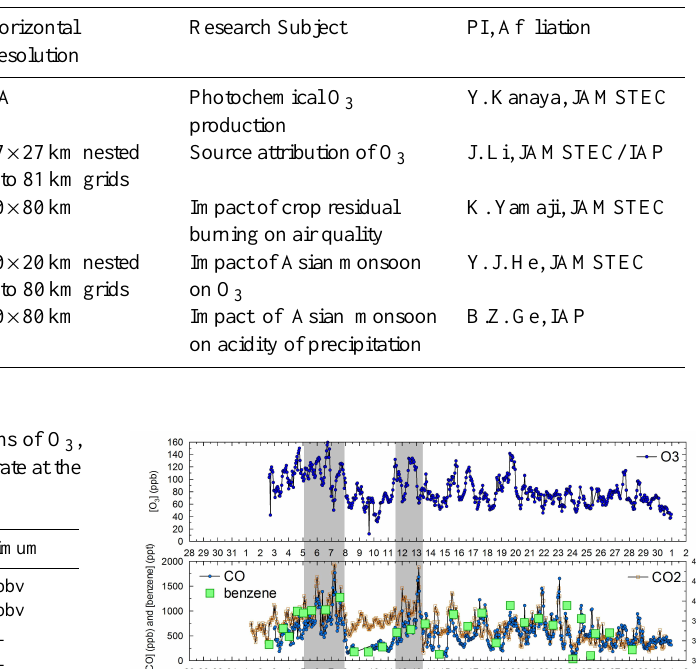
Table 2. MTX2006 modeling activities.